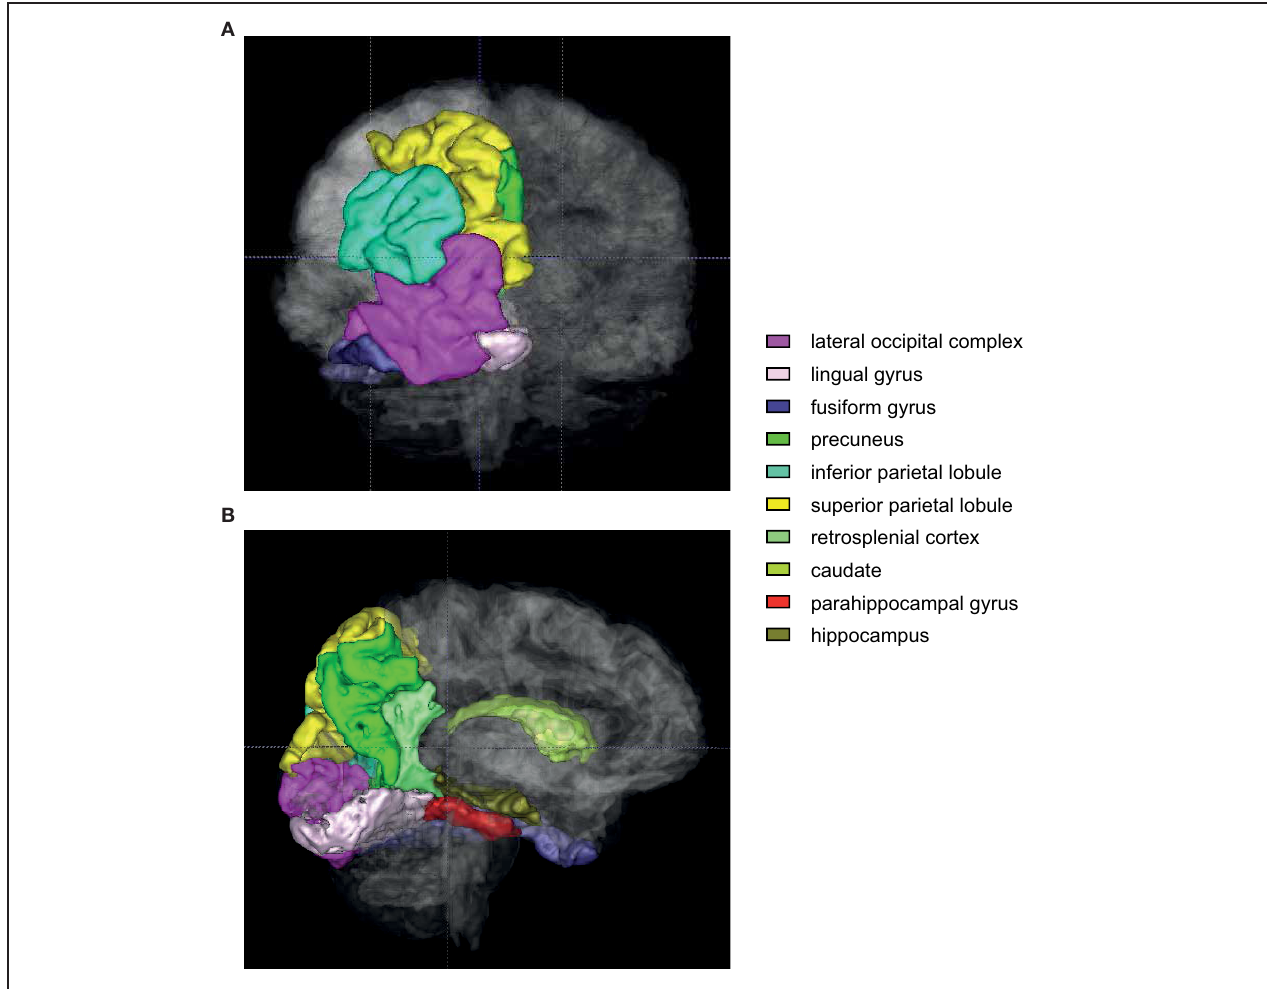
FIGURE 6 | An illustration of regions of interest in human VR contextual response-selection task. Human brain regions (color-coded) that are consistently activated in contextual response-selection studies. (A) A posterior view of the brain. Regions of interest (left hemisphere only) were overlaid with the translucent whole brain. (B) A medial view of the same